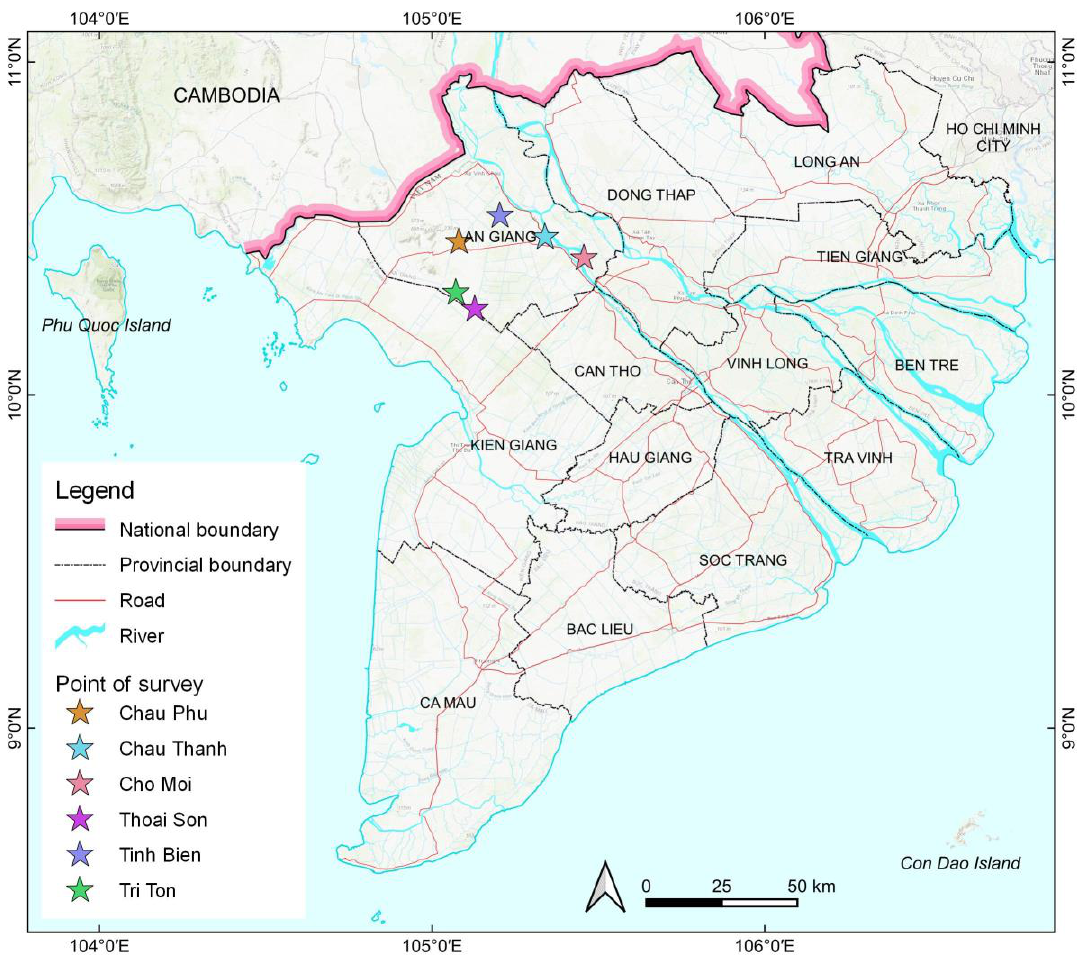
Figure 1. Locations of the study.